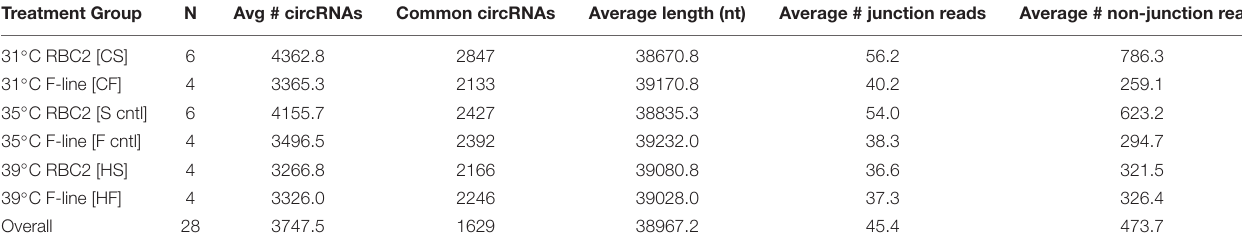
TABLE 1 | Summary of predicted circRNAs by treatment group 1 . Treatment Group Common circRNAs Average length (nt) Average # junction reads Average # non-junction reads